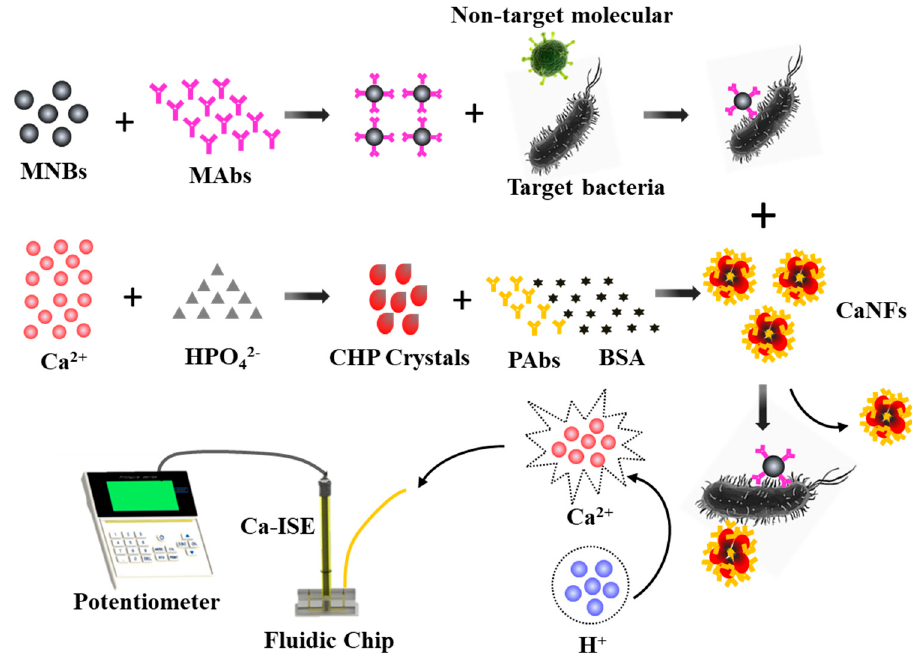
Scheme 1. Schematic of the proposed assay for sensitive detection of Salmonella Typhimurium.